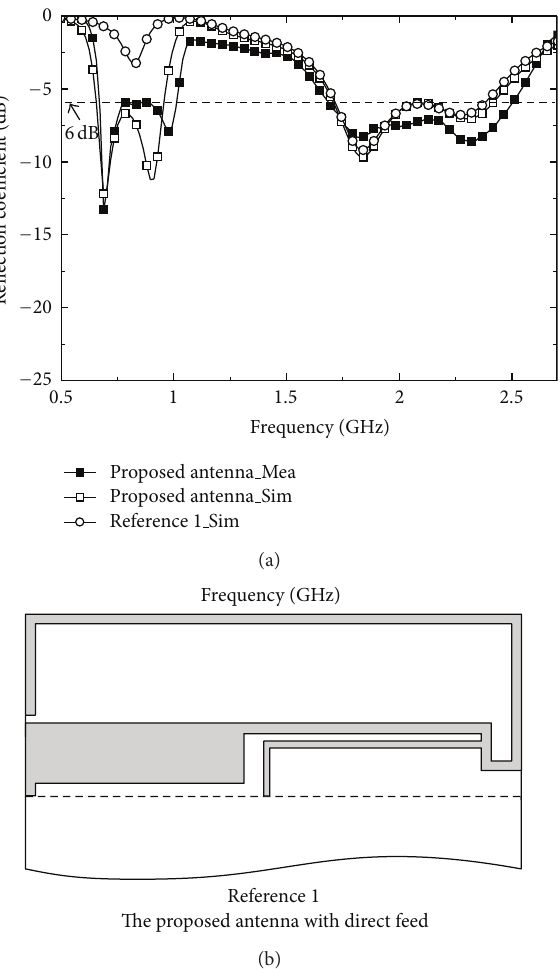
F 2: Simulated and measured re�ection coe�cients for the proposed antenna and reference 1.